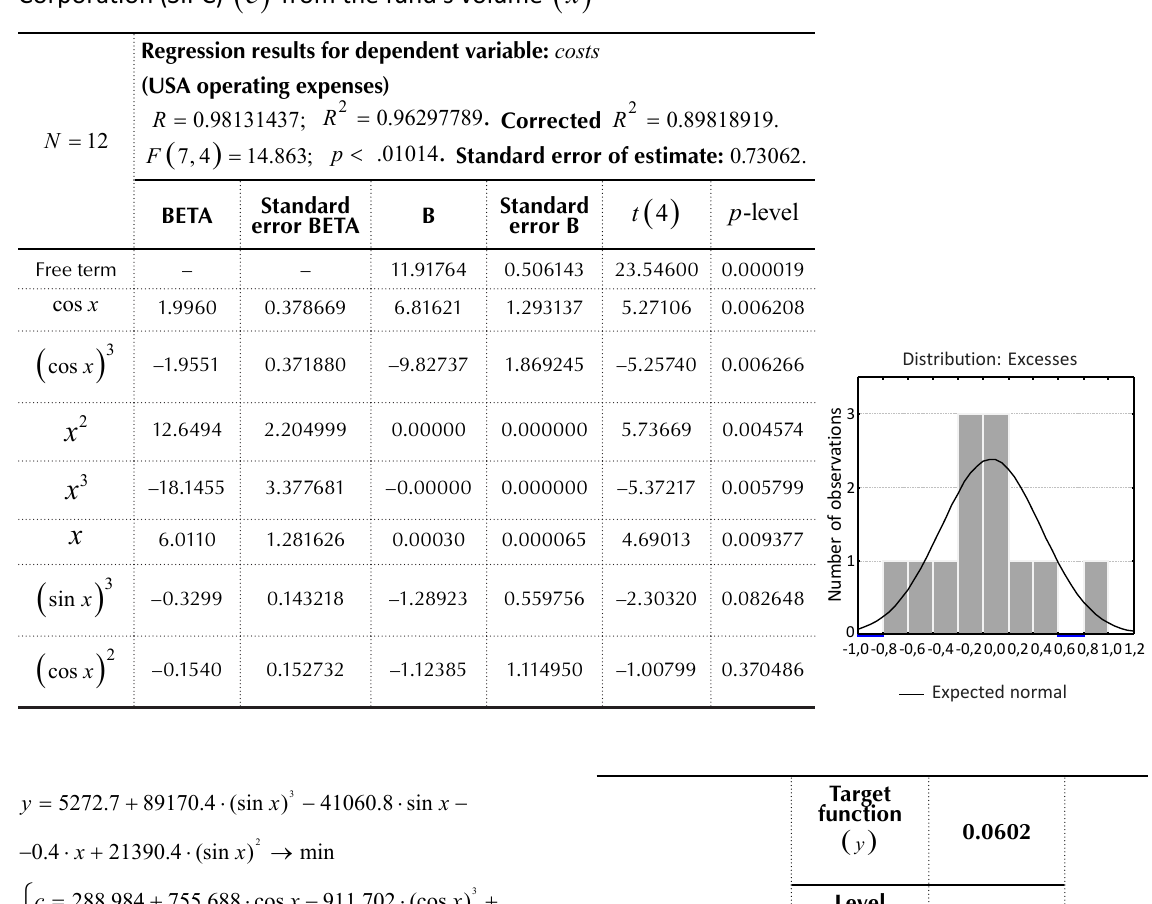
Table 2c. The results of regression for operating costs of the Securities Investor Protection Corporation (SIPC) ( ) e from the fund’s volume ( ) x